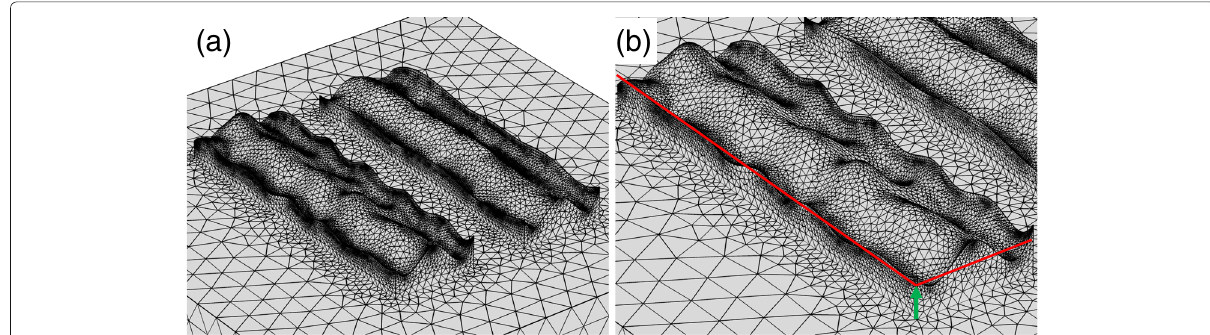
Fig. 8 a Roughed surface modeled using a periodic curve with a Gaussian white noise. b The base thickness indicated by the green arrow is varied in the